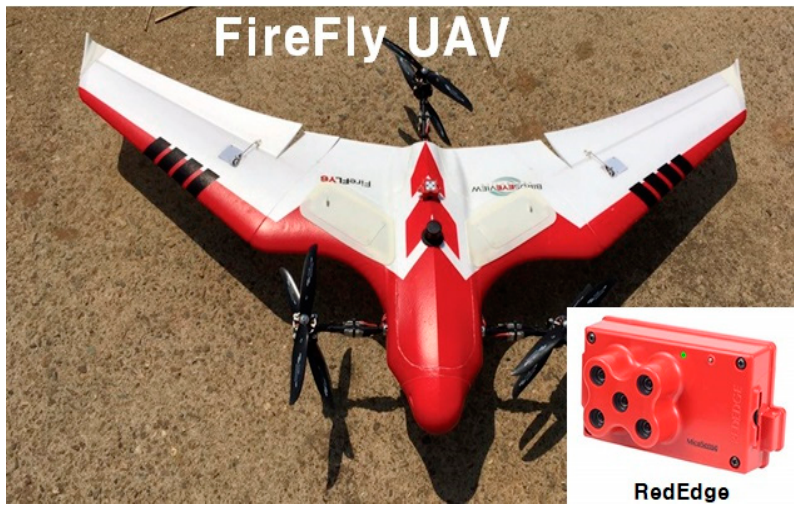
Figure 2. Firefly UAV and RedEdge multispectral camera. Table 1. Specifications of the Firefly UAV.